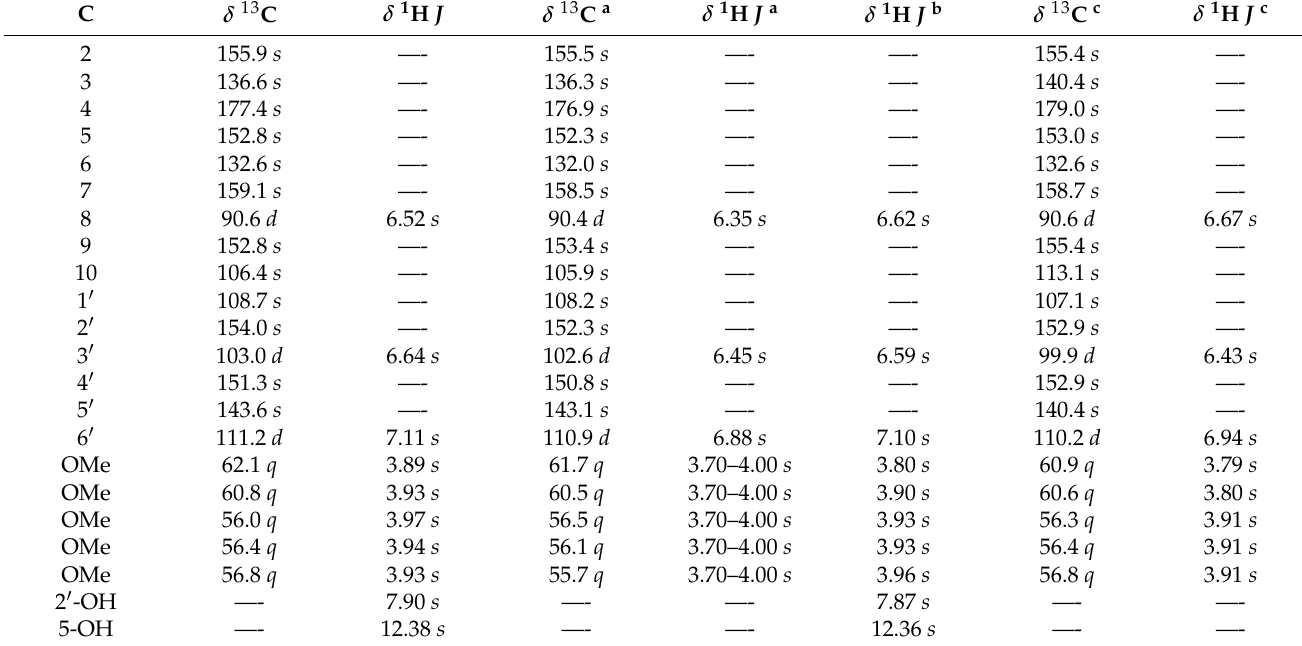
Table 1. NMR spectrometric data for brickellin (2 (cid:48) ,5-dihydroxy-4 (cid:48) ,3,5 (cid:48) ,6,7-pentamethoxyflavone) at 400 MHz for 1 H and 100 MHz for 13 C in CDCl 3 . Data from the literature are also